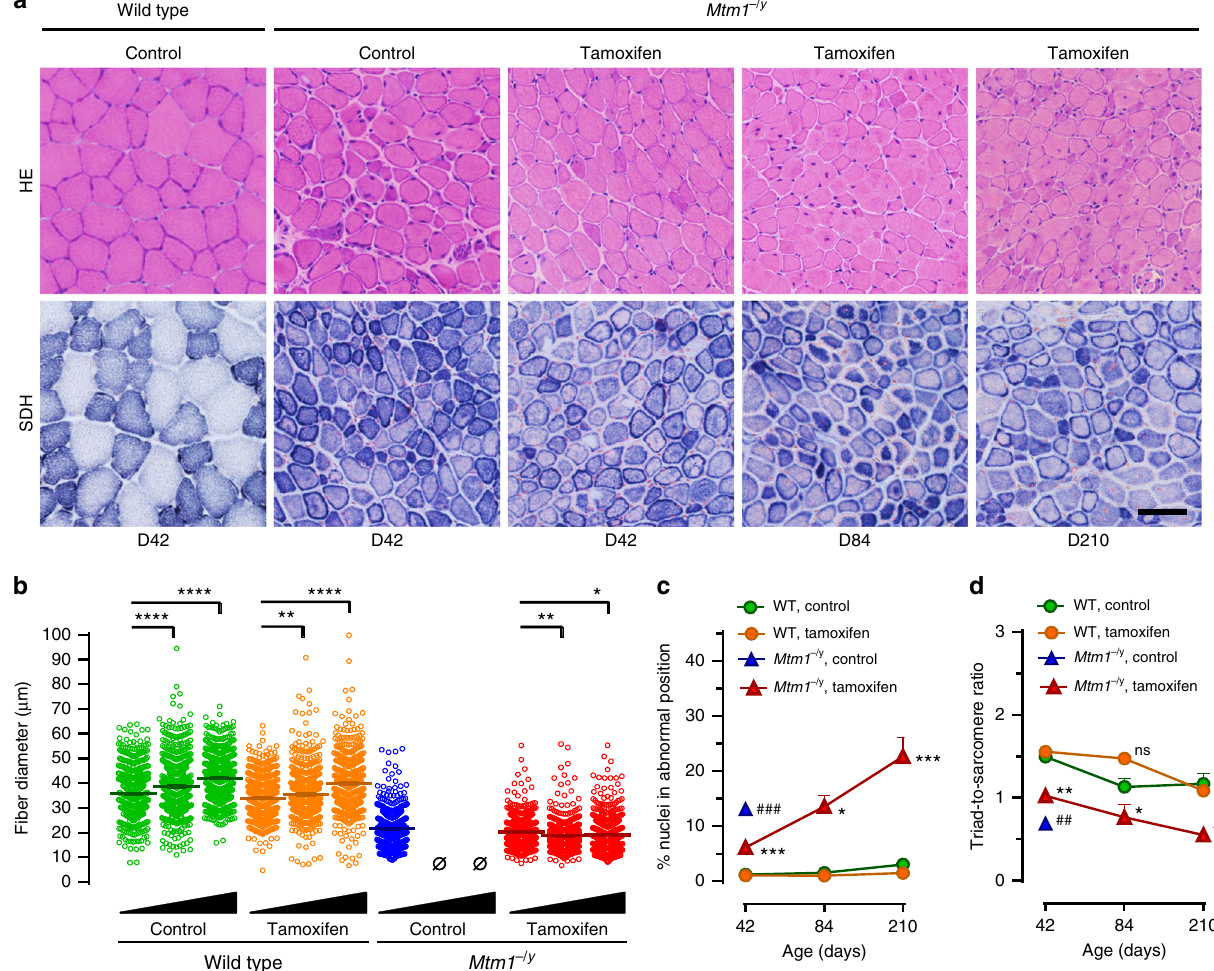
Fig. 6 Myopathic features after long-term tamoxifen treatment, Muscle structure and triads were examined by histology and transmission electron microscopy, respectively, in wild type (WT) and Mtm1 − /y mice during long-term treatment with tamoxifen (30 mg kg − 1 in diet). a Representative pictures of tibialis anterior (TA) sections from untreated WT and Mtm1 − /y mice at D42, and tamoxifen-treated Mtm1 − /y mice at D42, D84, and D210 stained with hematoxylin – eosin (HE) or for succinate dehydrogenase (SDH) activity. Muscle structure of Mtm1 − /y mice was stable over the duration of tamoxifen treatment. The bar represents 50 µ m. b Scatter plots showing the distribution of TA myo fi ber diameter in mice at D42, D84, and D210 (black triangles illustrate increasing age). Fiber size remained almost constant from D42 to D210. N = 600 myo fi bers per group. c The percentage of abnormally positioned nuclei (either internally or centrally located) in TA myo fi bres of mice at D42, D84, and D210 were counted from hematoxylin – eosin-stained sections. The density of abnormally positioned nuclei increased signi fi cantly with ageing. Mean ± s.e.m. of n = 2 – 5 TA per group. d The number of well-positioned triads relative to sarcomere number, determined from TEM pictures in TA from wild type and Mtm1 − /y mice, showed no signi fi cant change from D42 to D84. Black triangles illustrate increasing age (42 – 84 and 210 days). Mean ± s.e.m. of n = 2 – 3 TA per group. * P ≤ 0.05; ** P ≤ 0.01; *** P ≤ 0.001; **** P ≤ 0.0001. ## P